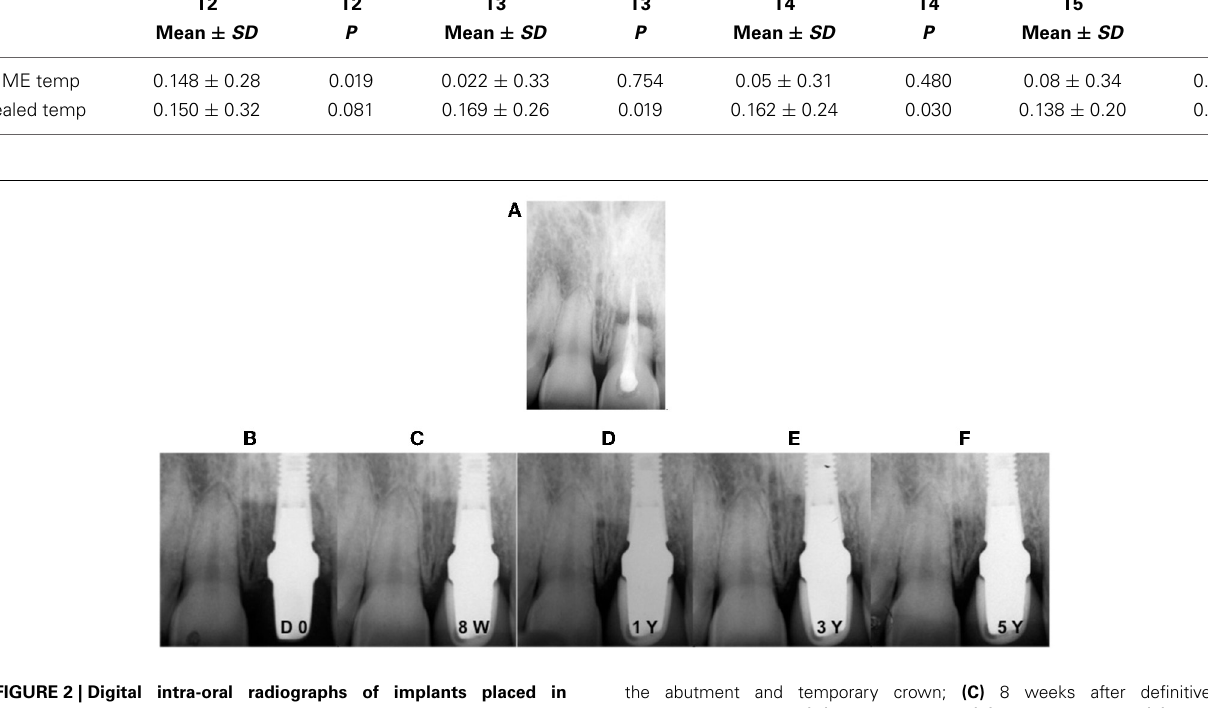
the abutment and temporary crown; (C) 8 weeks after definitive crown cementation; (D) after 1 year; (E) after 3 years; (F) after 5